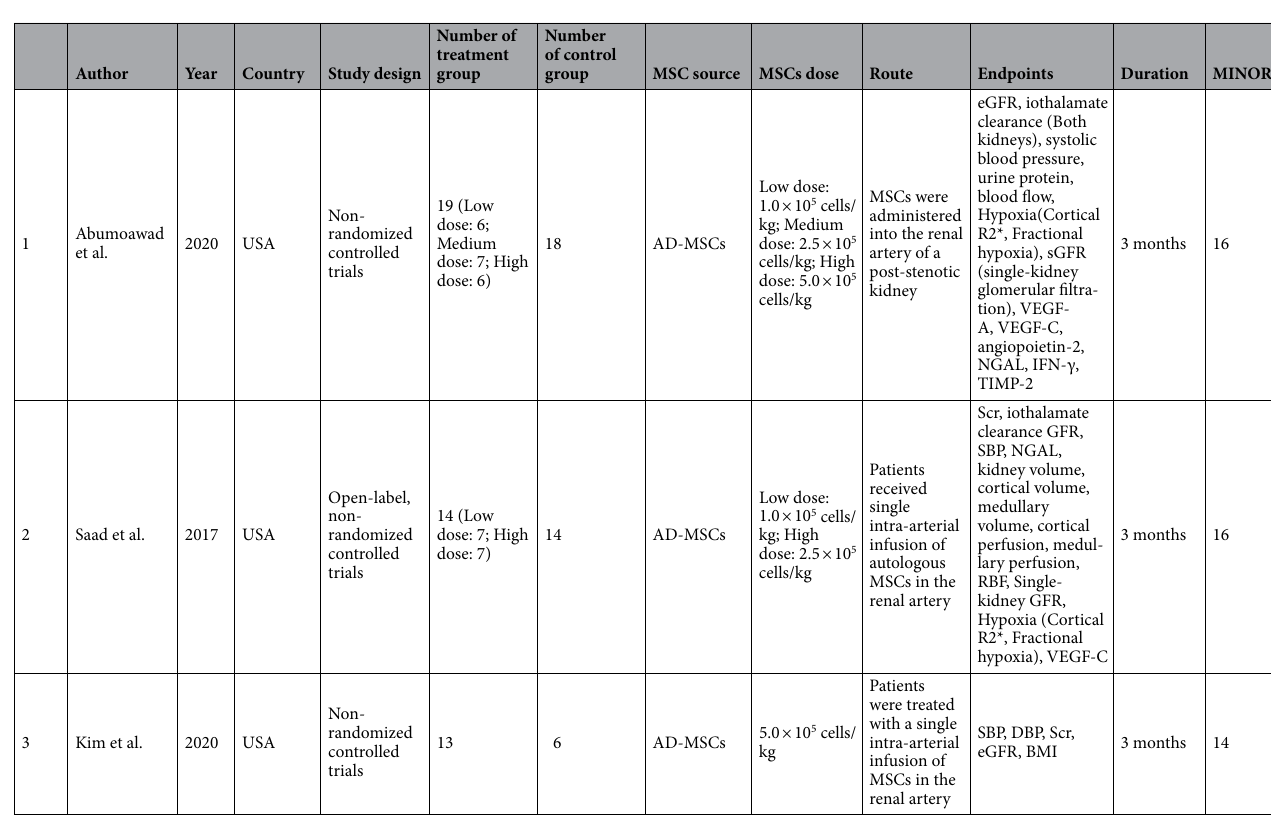
Table 1. Characteristics of preclinical studies.